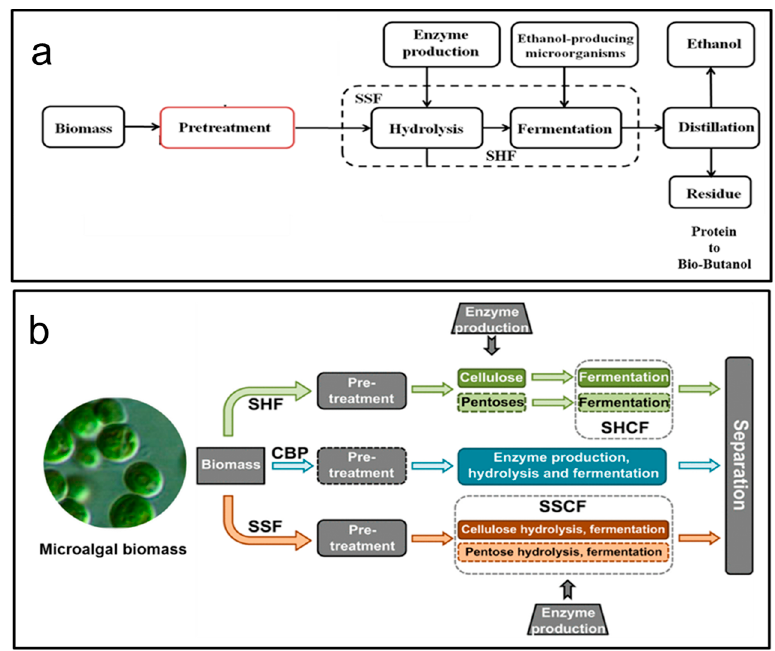
Figure 6. Process flow of separate hydrolysis and fermentation (SHF), simultaneous saccharification and fermentation (SSF) ( a ) and simultaneous saccharification and co-fermentation (SSCF) ( b ).